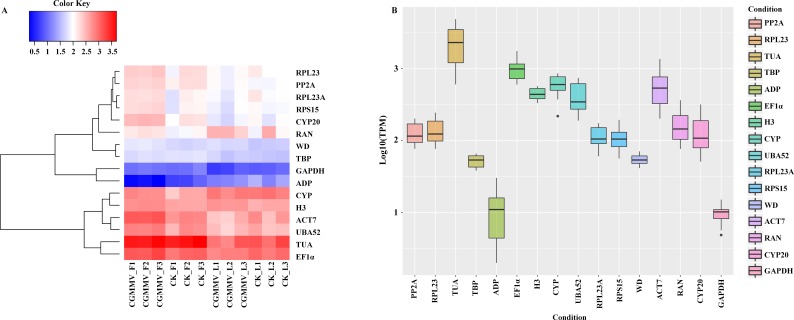
Characteristic expression of the universal genes in bottle gourd under CGMMV infection.(A) A heatmap was used to visualize the expression pattern of the two novel candidate RGs selected from RNA-Seq data and 14 commonly used RGs under CGMMV infection. (B) Expression levels and variations of the 16 common RGs under CGMMV infection.